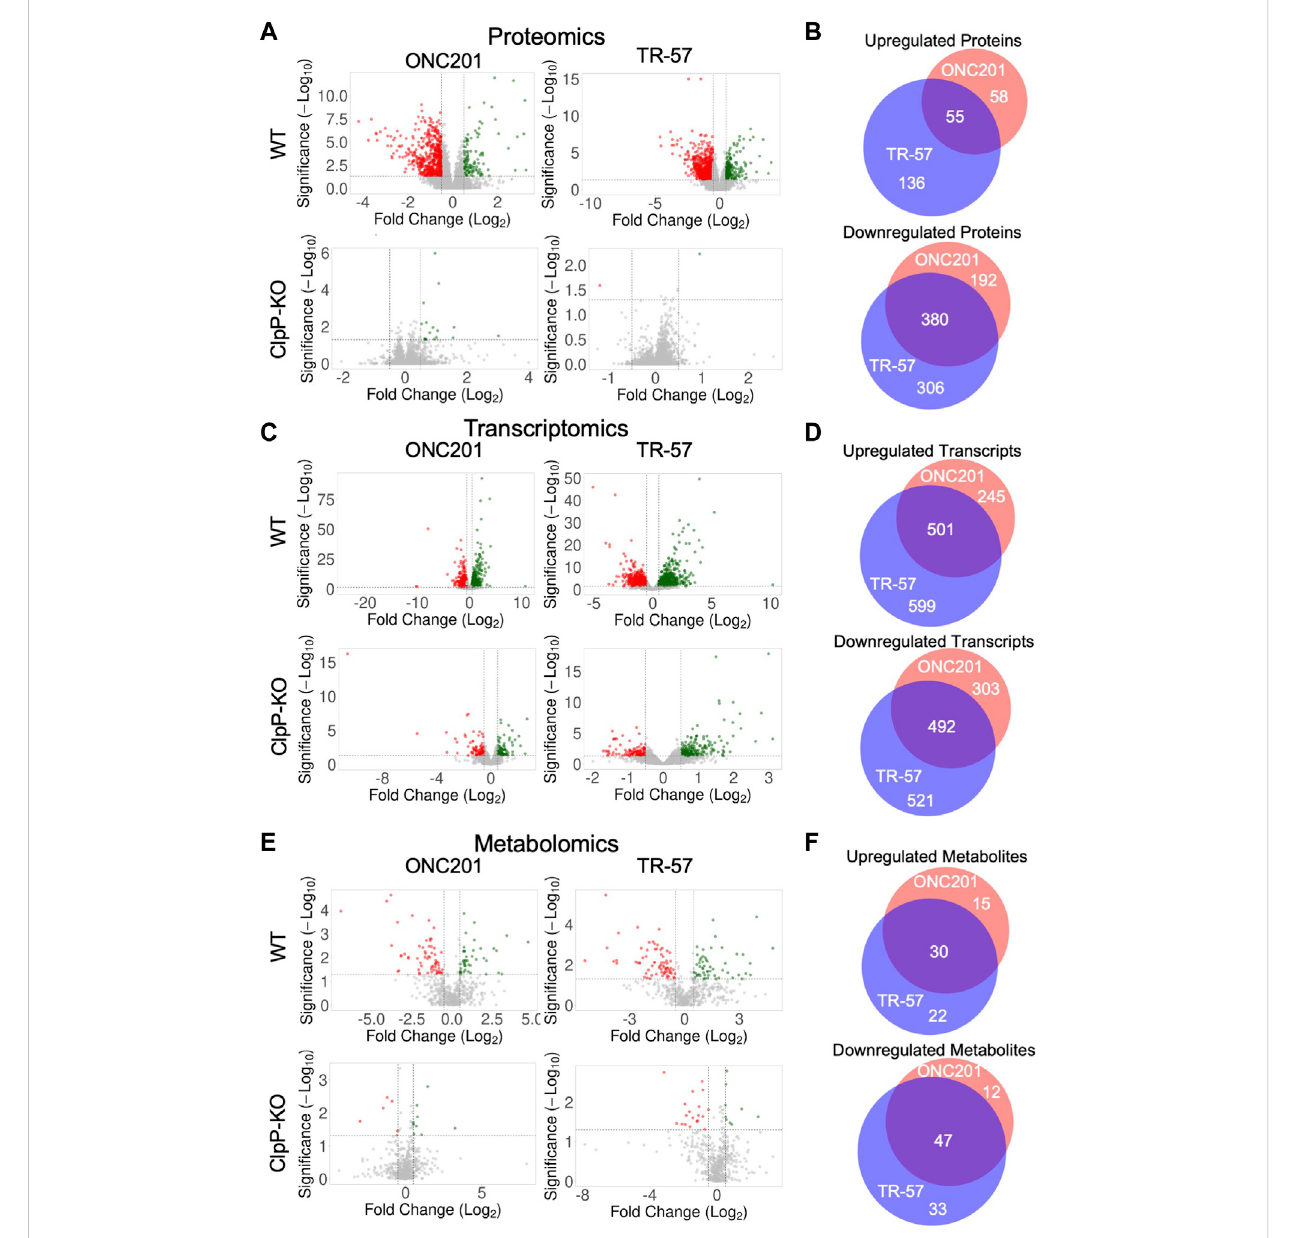
FIGURE 2 Analysis of omics data reveals signi fi cant and similar ClpP-dependent effects of ONC201 and TR-57 on triple-negative breast cancer cells. Wildtype (WT) and ClpP knockout (ClpP-KO) SUM159 cells were treated with 10 μ M ONC201 or 150 nM TR-57 for 24 h and analyzed for proteomic (A, B) , transcriptomic (C, D) , and metabolomic (E, F) perturbations. Volcano plots of each dataset are shown in (A, C) , and (E) . Axes are Log 2 (Fold Change) and -Log 10 (unadjusted p -value). Vertical dashed lines indicate fold change threshold (Log 2 (FC) > |0.5|) and horizontal dashed lines indicate signi fi cance threshold (-Log 10 ( p -value) > 1.3), N = 3. Venn diagrams of signi fi cantly perturbed proteins (B) , transcripts (D) , and metabolites (F) were generated from small molecules meeting the fold change and signi fi cance thresholds previously mentioned. Red: ONC201; blue: TR-57; purple: Both drug